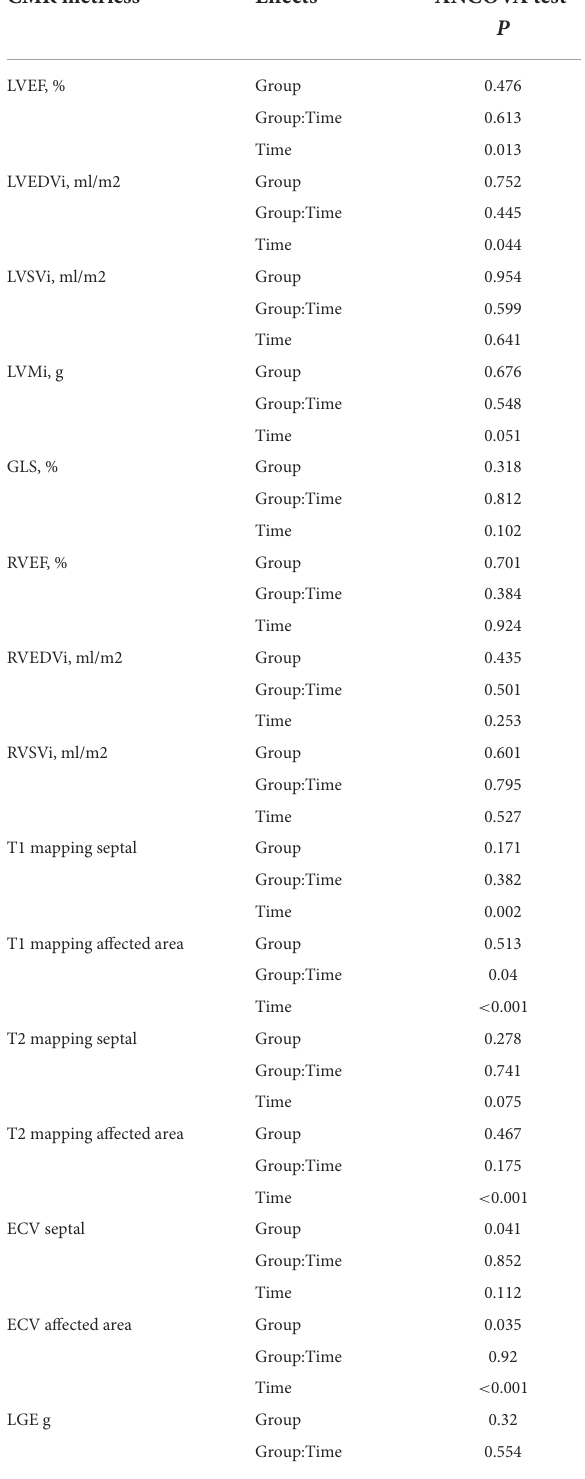
TABLE 4 Assessment of the trajectory of myocarditis patients after SARS-CoV-2 immunization and myocarditis patients unrelated to COVID-19 immunization or infection over the acute phase and follow-up using analysis of